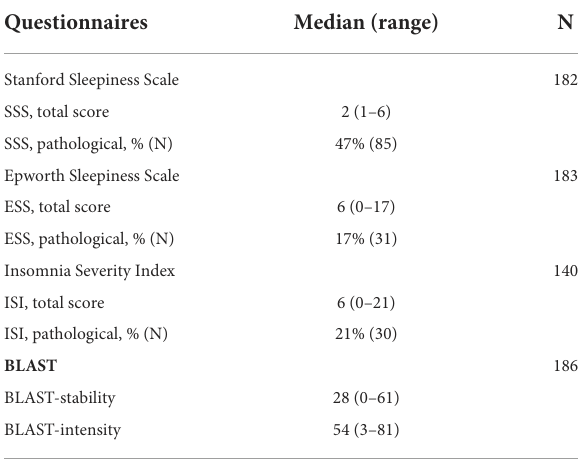
TABLE 1 Demographic, habitual sleep, and pre-travel sleep characteristics.